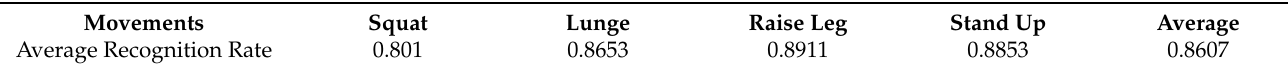
Table 8. Average recognition rate in 4 movements of the BP neural network for the ramp.